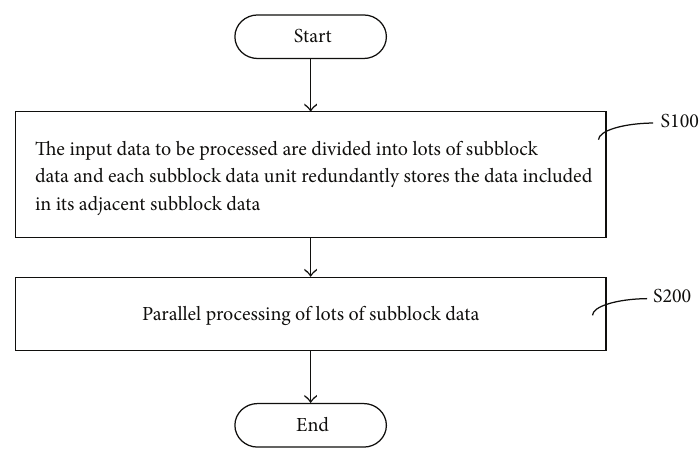
Figure 1: Flowchart of adjacent zero communication parallel cloud computing method.